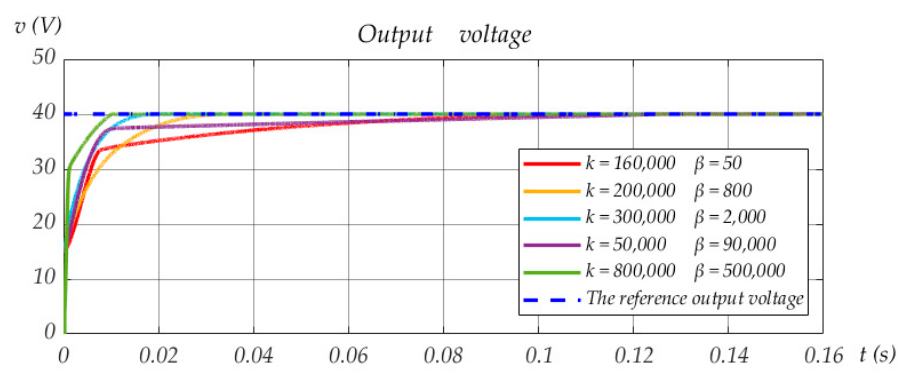
Figure 5. Transient of boost converter feeding CPL under the proposed controller with different parameters.